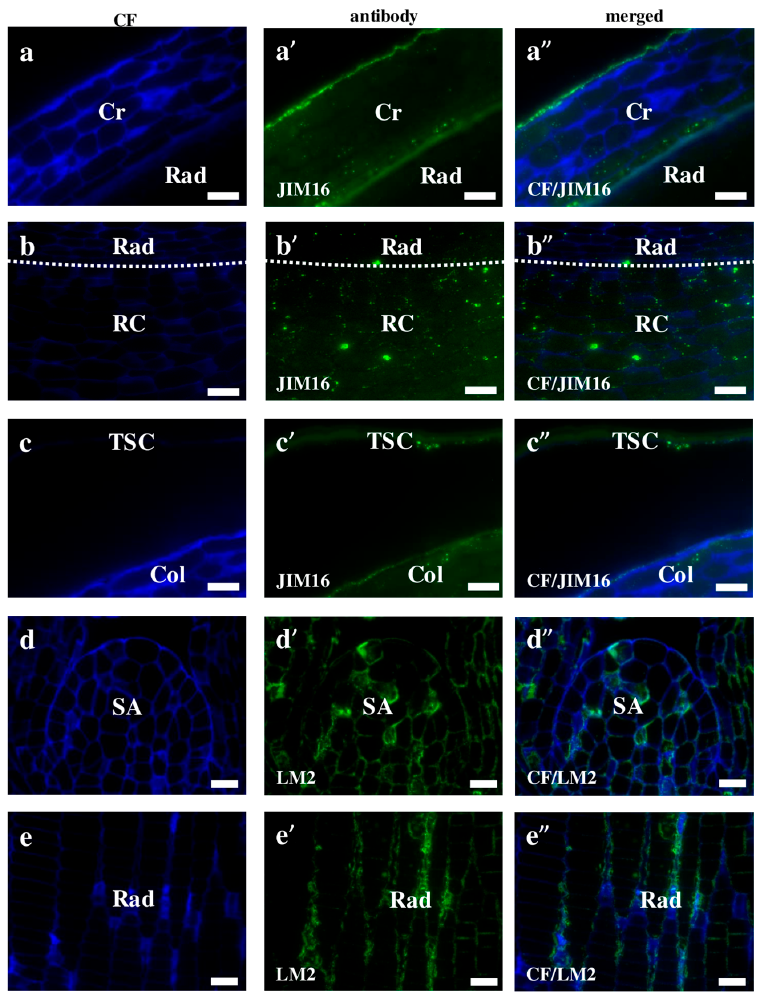
Figure 4. Immunolocalisation of arabinogalactan proteins in Brachypodium embryos. ( a – a” , b – b” , c – c” ) JIM16 with coleorhiza with radicula, radicula with root cap and coleoptile with the seed coat, respectively; Both ( d – d” ) shoot apex and ( e – e” ) radicula with LM2. Abbreviations: CF—calcofluor, Cr—coleorhiza, Col—coleoptile, Rad—radicula, RC—root cap, SA—shoot apex, and TSC—the